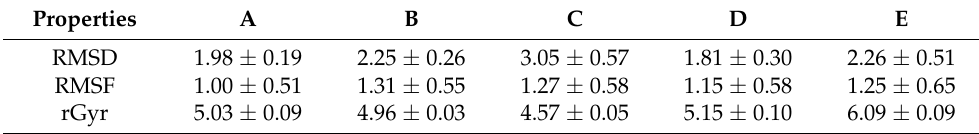
Table 4. The simulation properties of the complexes.